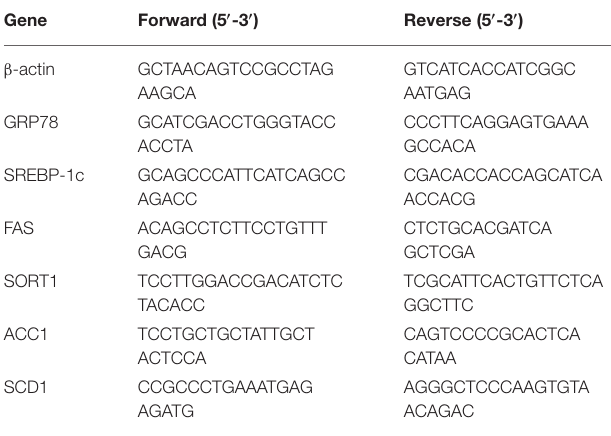
TABLE 1 | Sequences of primers used for real-time PCR